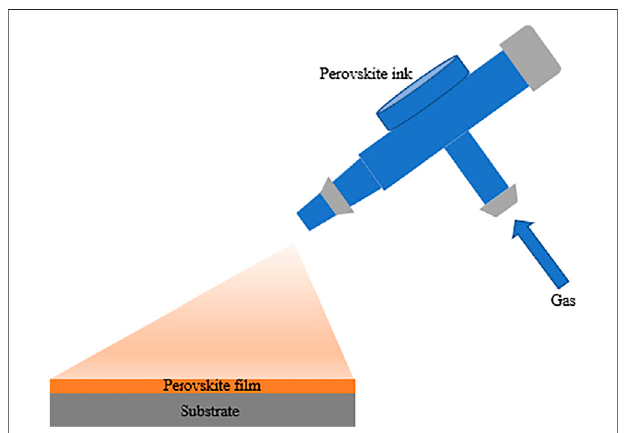
FIGURE 9 | Schematic of perovskite fi lm fabrication through spray- coating.